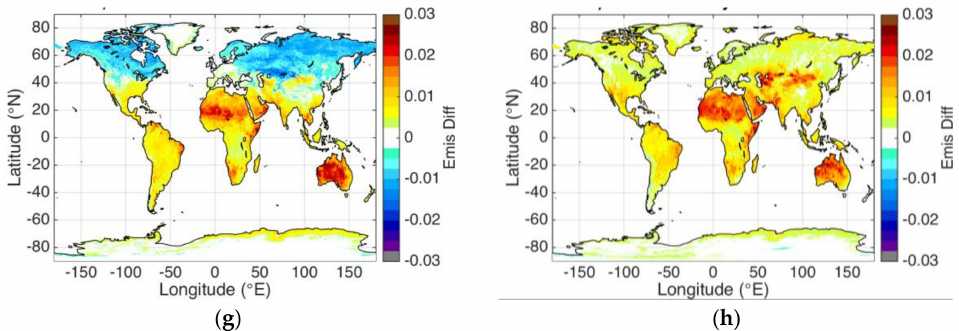
Figure 5. Difference of IASI minus CAMEL 8-year average emissivities at 0.25 ◦ × 0.25 ◦ spatial resolution for ( a ) January 3.6 µ m; ( b ) July 3.6 µ m; ( c ) January 8.6 µ m; ( d ) July 8.6 µ m; ( e ) January 10.8 µ m; ( f )